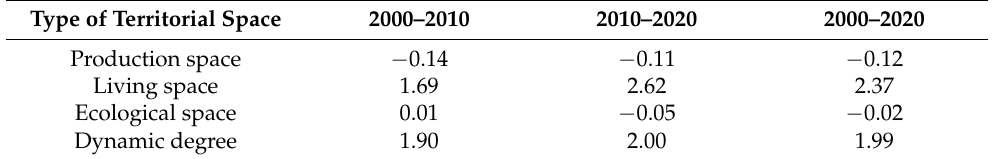
Table 5. The dynamic degree of territorial space in the Yangtze River Economic Belt from 2005 to 2015.